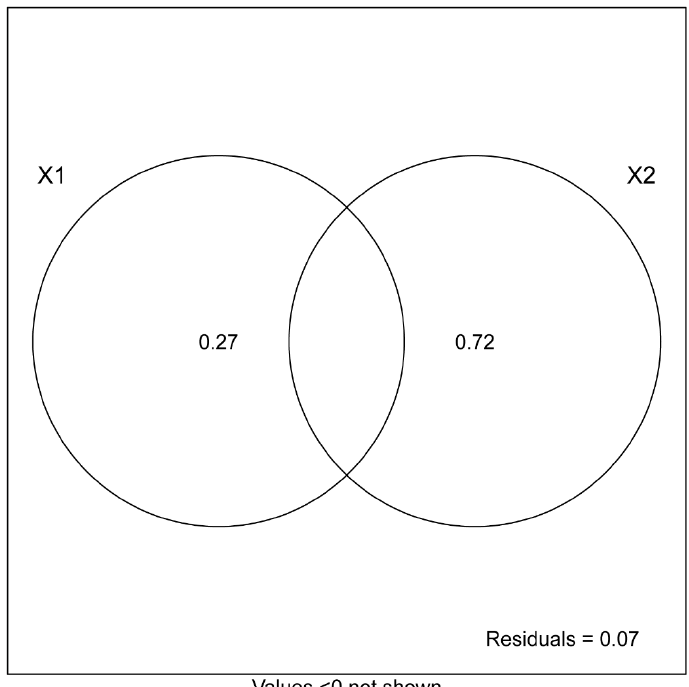
Figure 3. Partial redundancy analysis (RDA) for gap size, soil layer and microbial communities. X1: gap size; X2: soil layer.